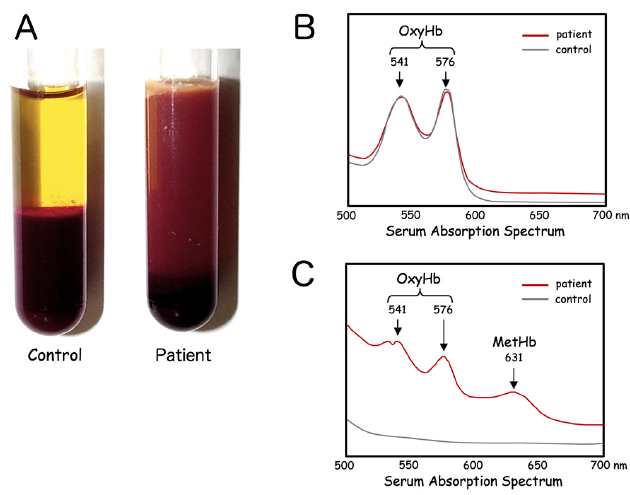
Figure 2. Serum characteristics of HO-1 deficiency. Patient serum separated immediately after blood drawing is characterized by a turbid, dark-brown color ( A ). Fresh hemolysate of the patient’s erythrocytes shows only the peaks of oxyhemoglobin (OxyHb) ( B ). Absorption spectrum of the patient’s serum reveals inclusion of large amounts of both OxyHb and methemoglobin (MetHb) ( C